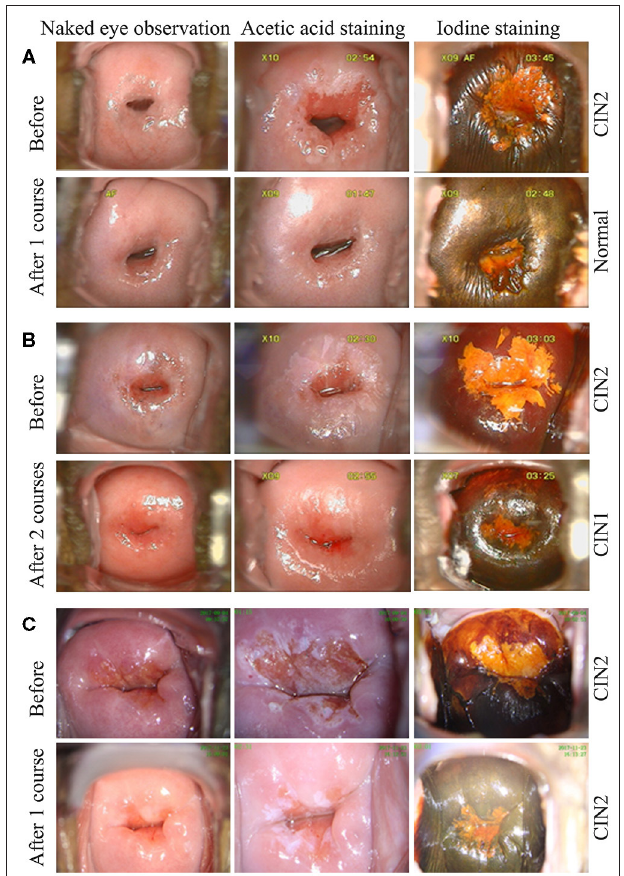
FIGURE 1 | Observation via colposcopy before and after REBACIN ® treatment. After one (A, C) or two (B) courses of REBACIN ® treatment, the examination of TCT and cervical histopathology showed normal TCT (A) , CIN1 (B) and CIN2 (C) , respectively in lower panels. Upper panels in (A-C) showed the examination before REBACIN ® treatment; representative pictures were shown.